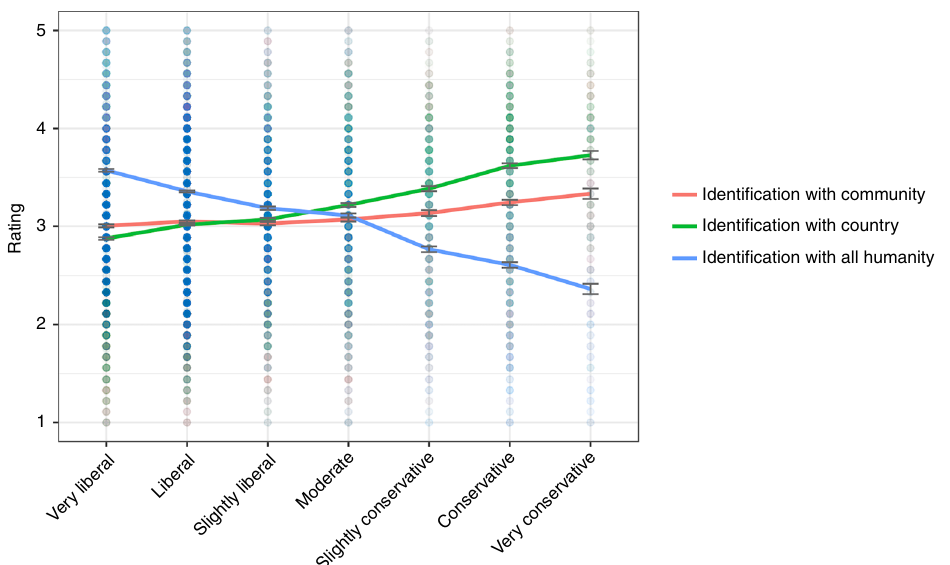
Fig. 3 Identi fi cation by political ideology, Study 1c. Error bars represent standard errors, solid lines indicate means. Source data are provided as a Source Data fi